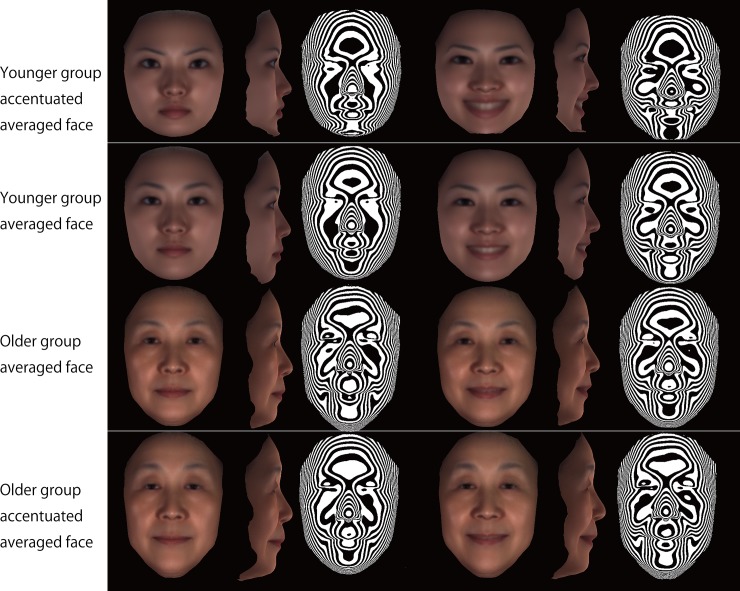
Computer-generated model faces to facilitate intuitive understanding
of aging effects by illustrating site-specific accentuated facial
topography.Left, frontal view of rest posture; second from left, lateral view of
rest posture; third from left, contour map of rest posture; third from
right, frontal view of smile posture; second from right, lateral view
from the right; right, contour map of smile posture.